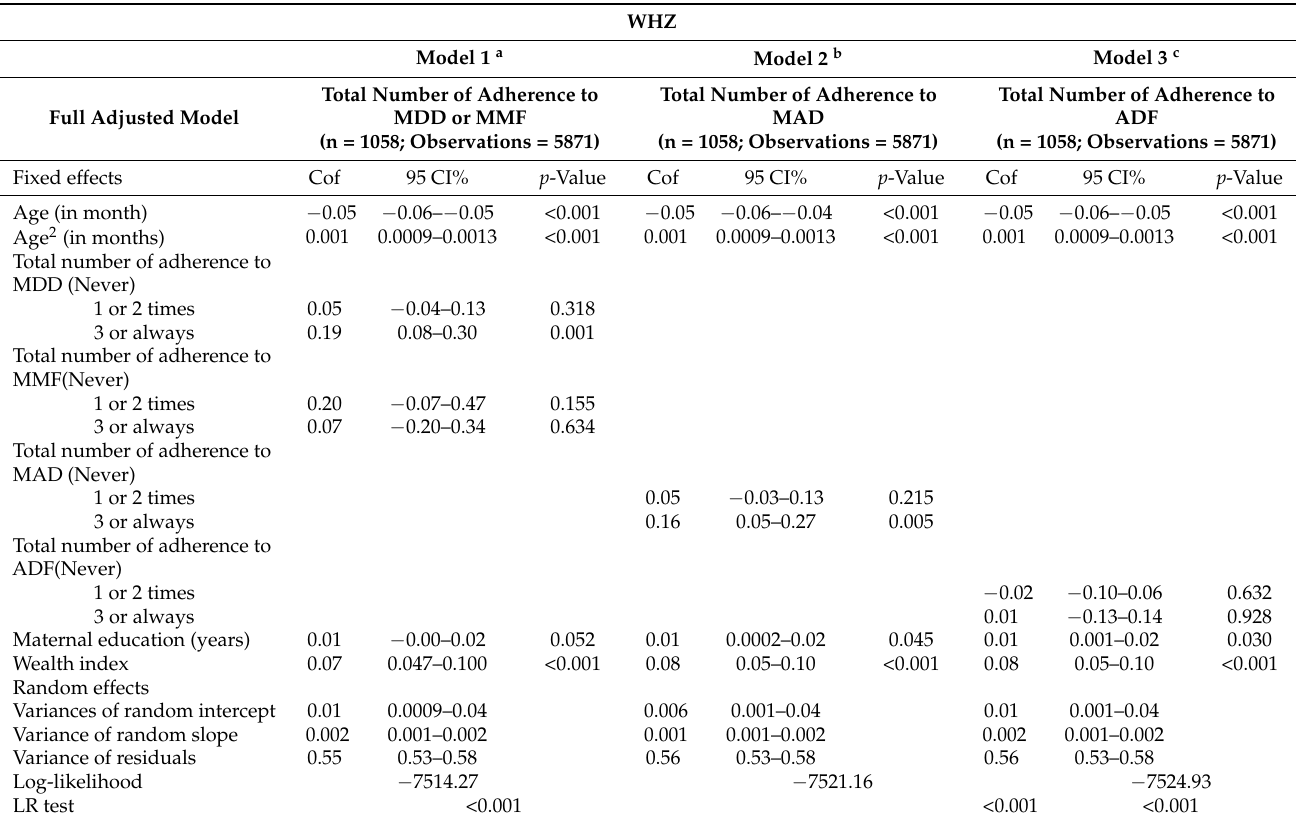
Table 5. The relationship of adherence to age-appropriate feeding practices and other determinants with child Weight-for- Height